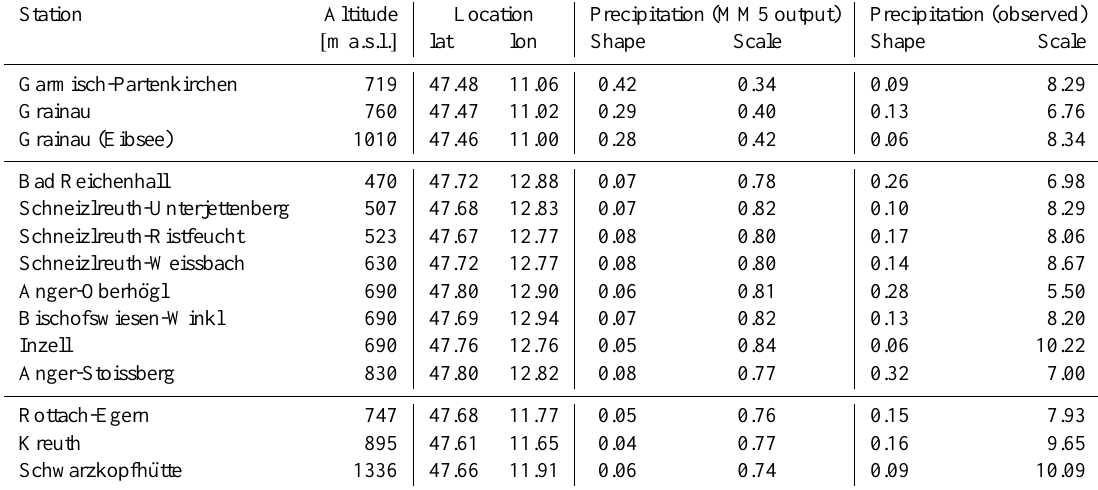
Table 1. Station informations corresponding to 3 chosen MM5 grid cells, shape (tail index), and scale parameters of the fitted Generalized Pareto Distribution (GPD) for positive pairs of modelled and observed precipitation